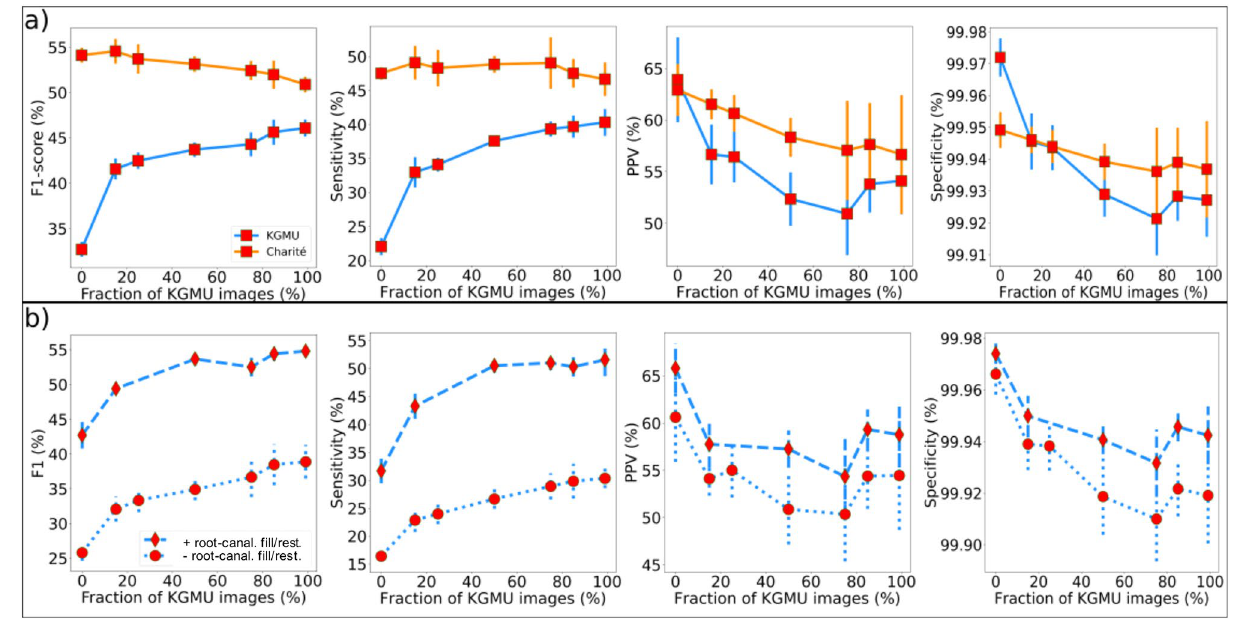
Figure 3. ( a ) The model performance on the Charité and KGMU test sets with different fractions of KGMU images in the training set (markers and error bars denote the mean and standard deviation of the scores over the set of the 5 best models selected from cross-validation, respectively). ( b ) Model performance for the subsamples of the KGMU dataset with and without root-canal fillings and restorations being present. PPV Positive predictive